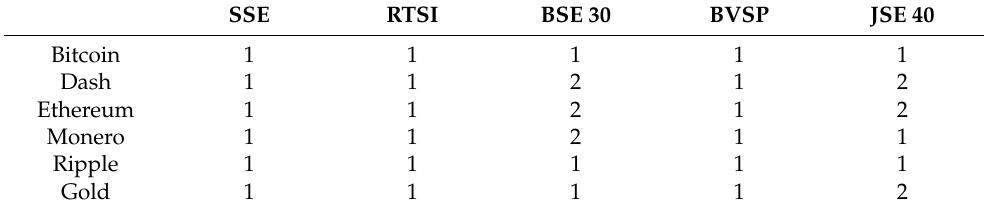
Table 4. Results of the Johansen cointegration